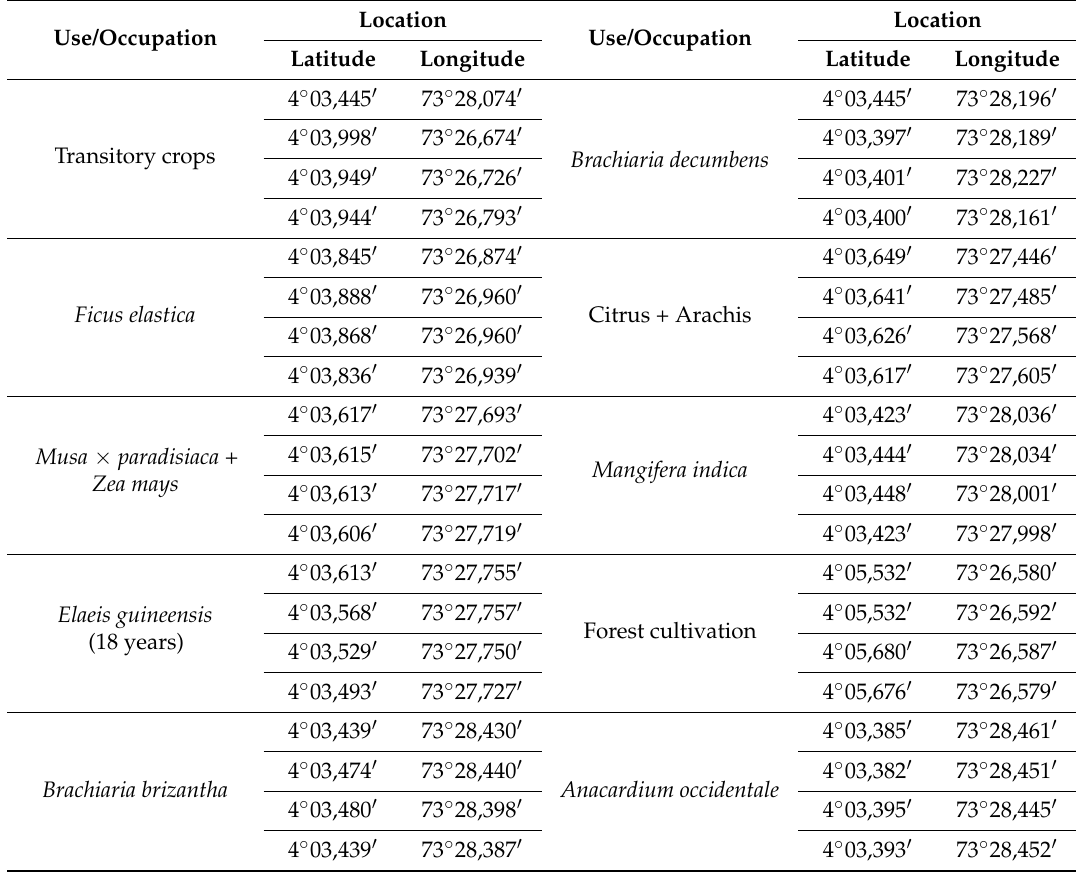
Table 1. Geographical location of sampling soil